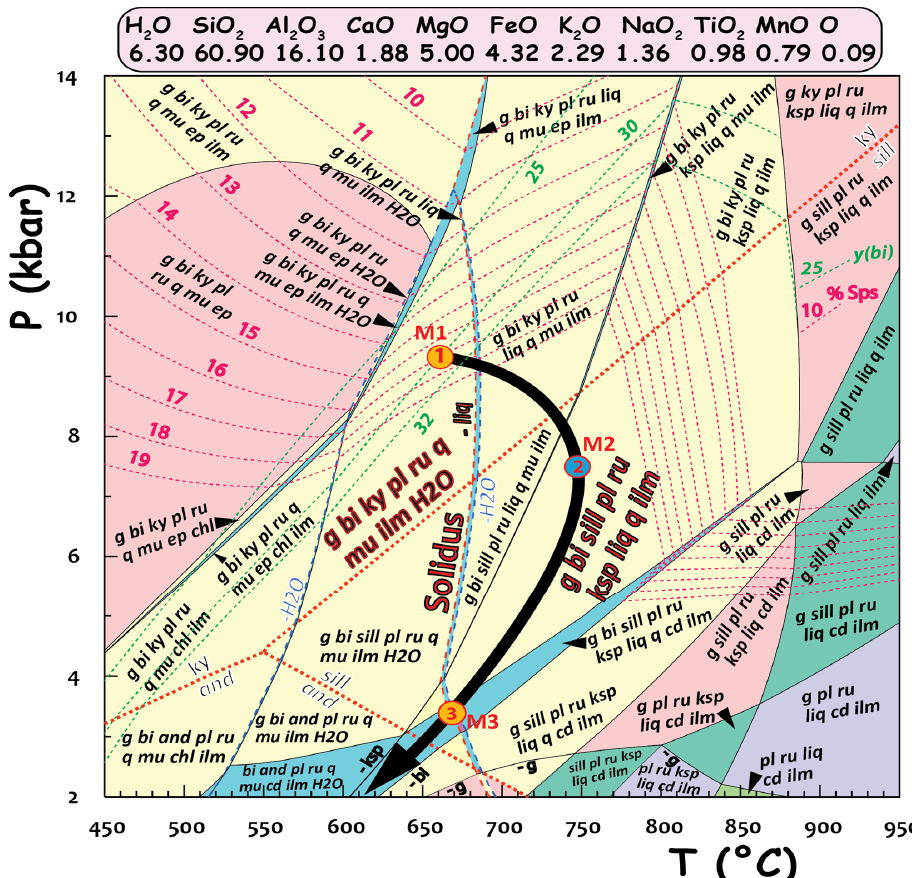
Figure 10. P-T pseudosection constructed in the MnNCKFMASHTO chemical system using the software THERMOCALC, with the melt-reintegrated bulk compositions with 6 mol.% added melt. The blue dashed line is the H 2 O-saturated solidus. The red bold fonts refer to the observed early metamorphic peak and syn-thermal peak mineral assemblages. The bulk composition (in mol.%) was calculated with the addition of 6 mol.% melt into the original migmatitic paragneisses composition (Figure 9) and is given above the pseudosection. The dashed bold red line represents the solidus. The red and green dashed lines represent isopleths of the spessartine (Sps) content of garnet and y(bi) in biotite, respectively. The semitransparent blue and yellow circles, marked with numbers 1, 2, and 3, refer to the P-T conditions of the early metamorphic peak, syn-thermal peak, and retrograde assemblages, respectively, constrained by the composition isopleths of garnet and biotite. See text for further details.